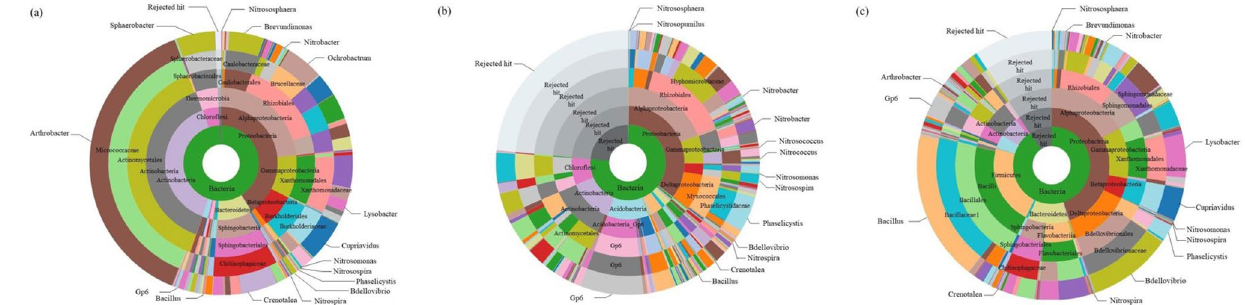
Figure 5. Microbial phase analysis of the inoculated carriers, uninoculated material, and liquid “multiple parallel mineralization” (MPM) culture. Sunburst display of species annotation. The innermost circles represent the highest level in the taxonomic hierarchy (i.e., kingdom); moving towards the outer circles represents a move towards lower taxonomic levels (with genus as the outermost level). Sector areas indicate the relative proportions of operational taxonomic unit annotation results. ( a ) Rockwool as the microorganism carrier (32,130 sequences). ( b ) Bark compost as the microbial inoculum (38,114 sequences). ( c ) Liquid culture MPM solution with 10 g/L of bark compost as the microbial inoculum and 1 g/L of fish fertilizer incubated in a flask for 2 weeks at 25 °C, with shaking at 120 rpm (50 381 sequences).